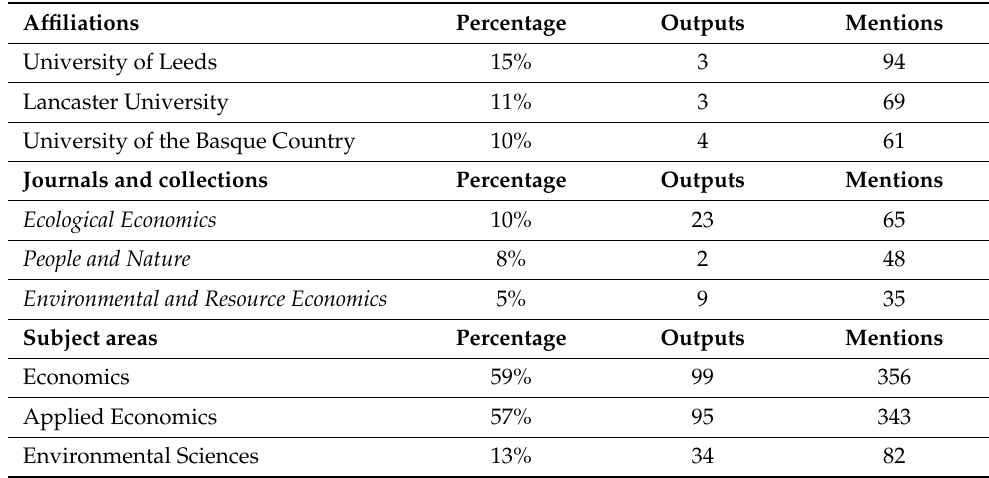
Table 1. The top 3 pieces of Altmetric data showing affiliations, journals and collections and subject areas in “Environmental Valuation”.